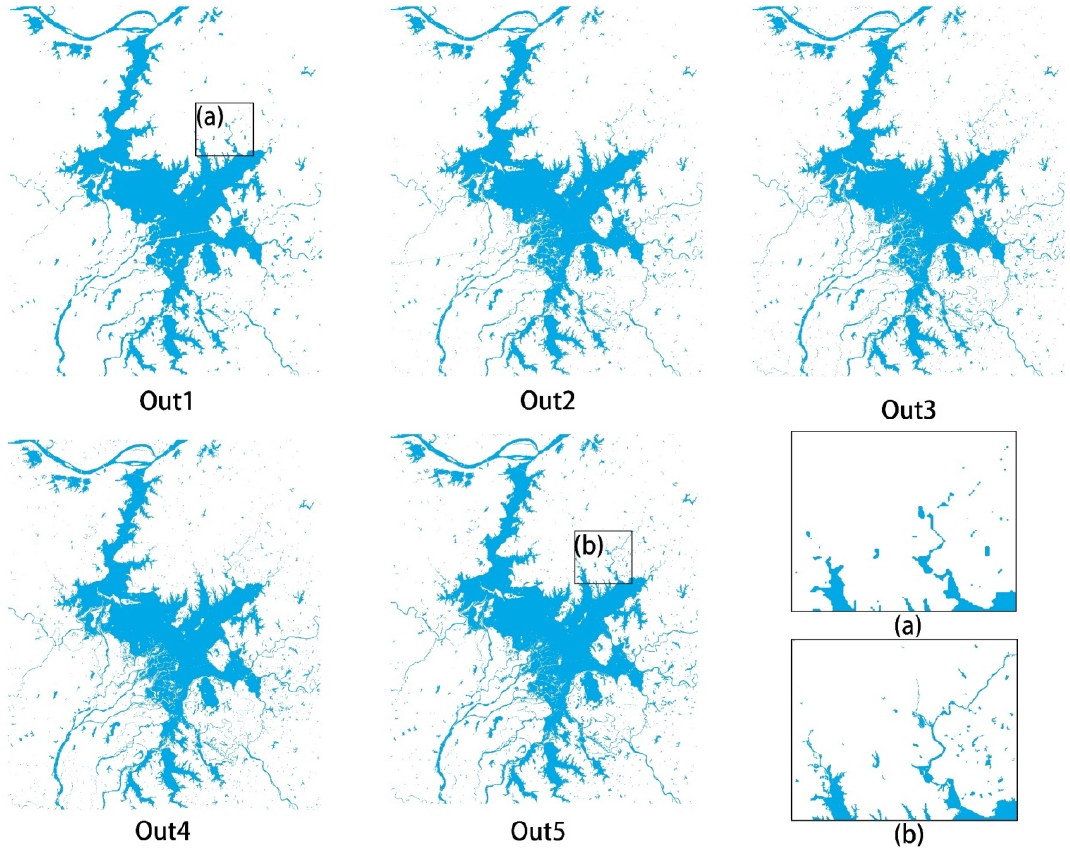
Figure 14. Stage output results: ( a , b ) zoom in for details of Out1 and Out5, respectively.